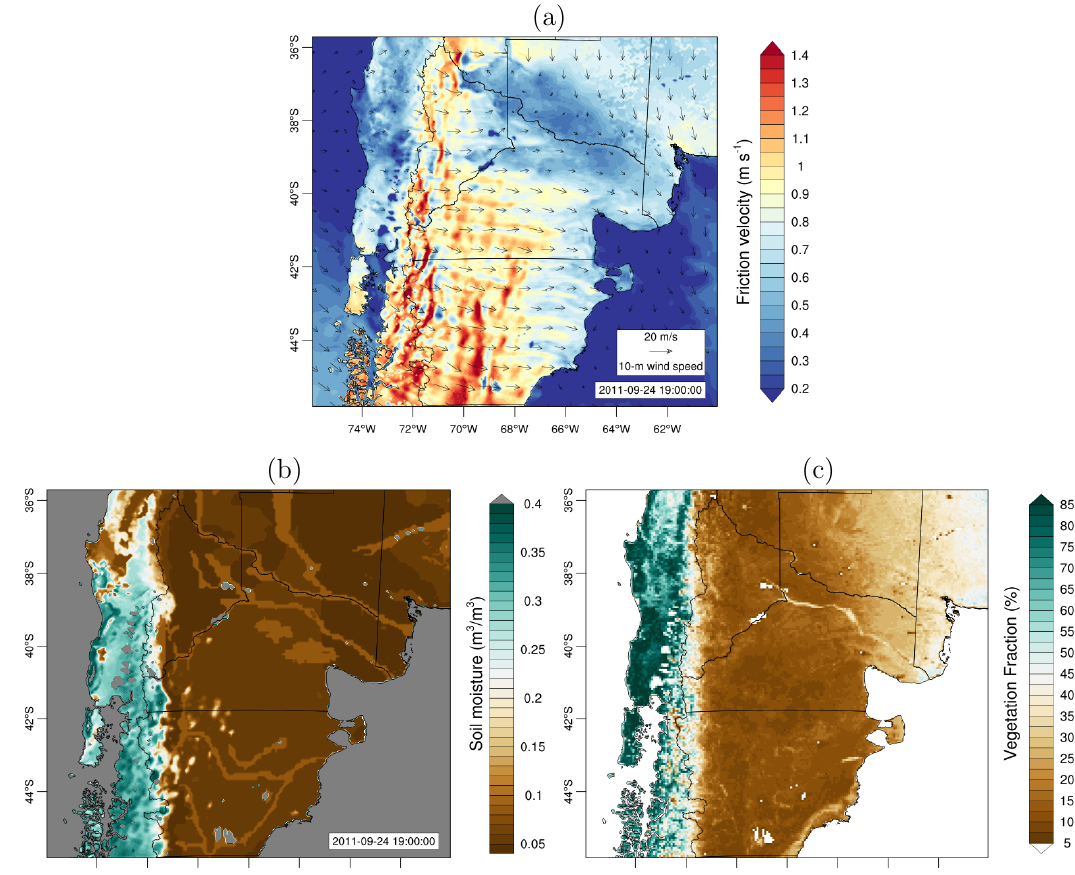
Figure 12. WRF fields required by the emission scheme at 6-km resolution for 24 September 2011 at 19:00 UTC: ( a ) friction velocity and 10-m wind vectors; ( b ) volumetric soil moisture; and ( c ) vegetation cover fraction. Two regions with contrasting environmental conditions for aeolian erosion can be recognised, with ideal conditions for ash resuspension across the dry regions east of the